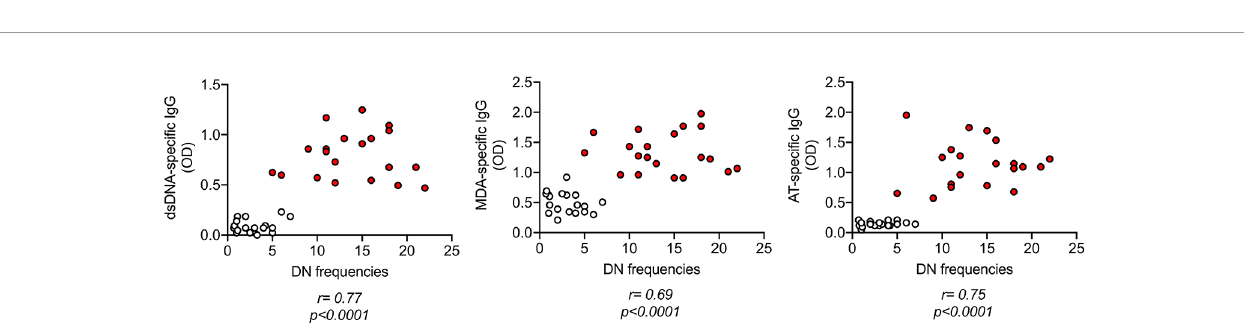
FIGURE 3 | IgG antibodies speci fi c for dsDNA, MDA, adipocyte-derived antigens are positively associated with blood frequencies of DN B cells. IgG antibodies were measured in plasma as indicated in Figure 1 . DN B cell frequencies were measured by fl ow cytometry as indicated in Figure 2 . Correlation coef fi cients and p values are shown for each antibody speci fi